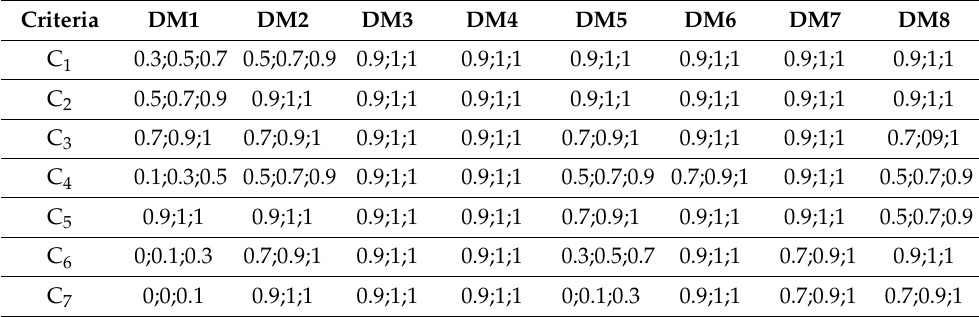
Table 6. Transfiguration of importance weights of decision criteria into positive triangular fuzzy numbers.